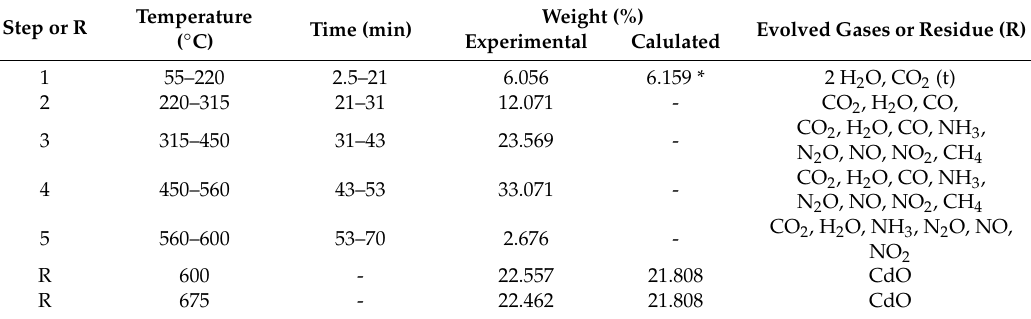
Figure 1. Weight loss versus temperature (in the range r.t. to 775 °C) in the thermogravimetric analysis of compound 1 (sample: 12.29 mg). Table 2. Summary of the results and assignations in the thermogravimetric analysis of compound 1 .